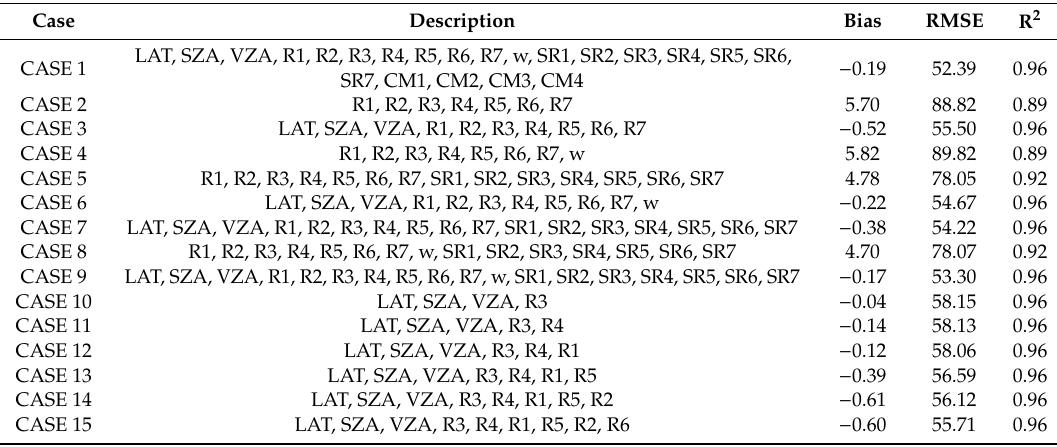
Table 5. The description and error statistics of the proposed cases for NSSR